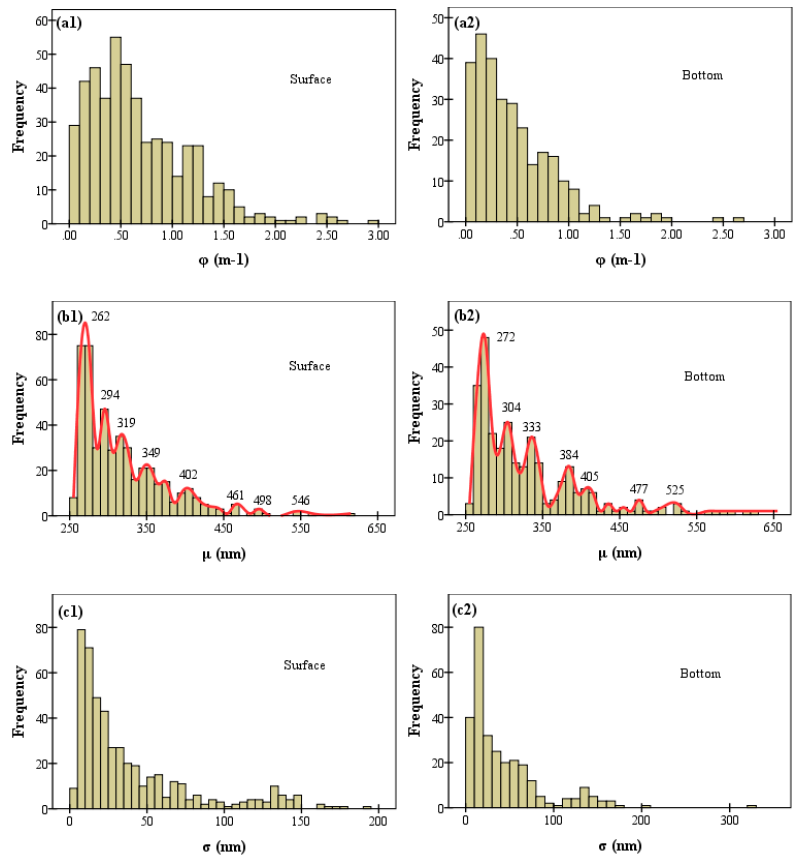
Figure 8. The frequency histogram of ( a ) peak height ( φ ), ( b ) peak position ( µ ), and ( c ) curve width ( σ ) of the 479 Gaussian components at the surface (left column) and 288 components at the bottom (right column). Eight groups were identified from the surface components and labeled in ( b1 ); seven groups were identified from the bottom components and labeled in ( b2 ).